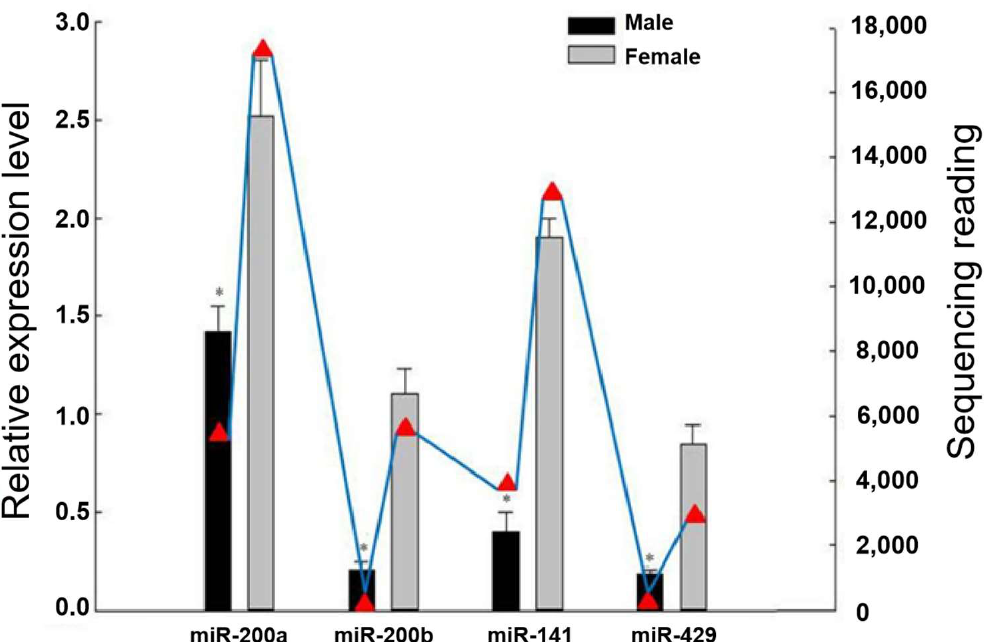
Figure 1. The relative expression of the miR-200 family in the male and female gonads of Japanese flounder. Note: The blue line of the triangle indicates the results of the miRNA high-throughput sequencing, with its Y -axis on the right. The bar graph shows the results of the fluorescence quantification of each member of the miR-200 family, with its Y -axis on the left. * Indicates a statistically significant difference ( p < 0.05).